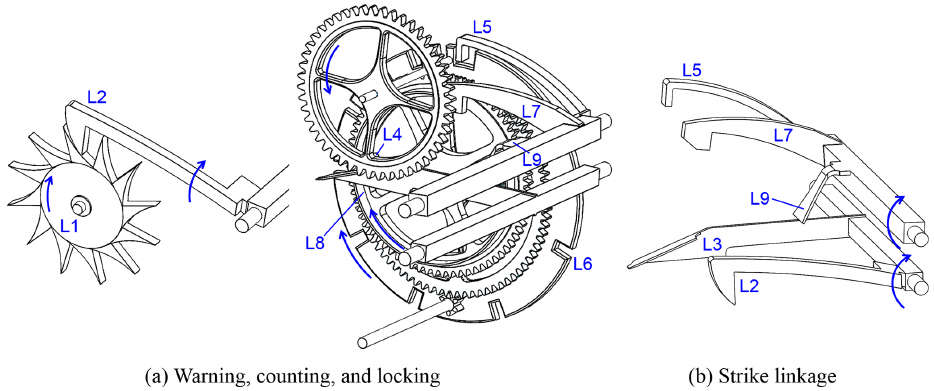
Figure 28. Structure and operation of the N10 striking trigger. (The trigger is similar to that of N5.)